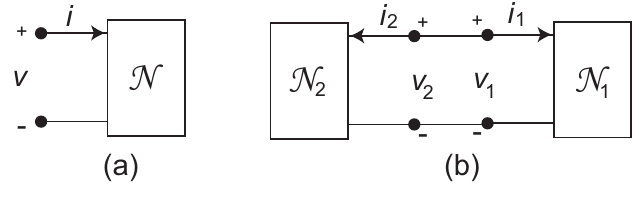
Figure 1. ( a ) One-port circuit network. ( b ) Interconnection of two circuit